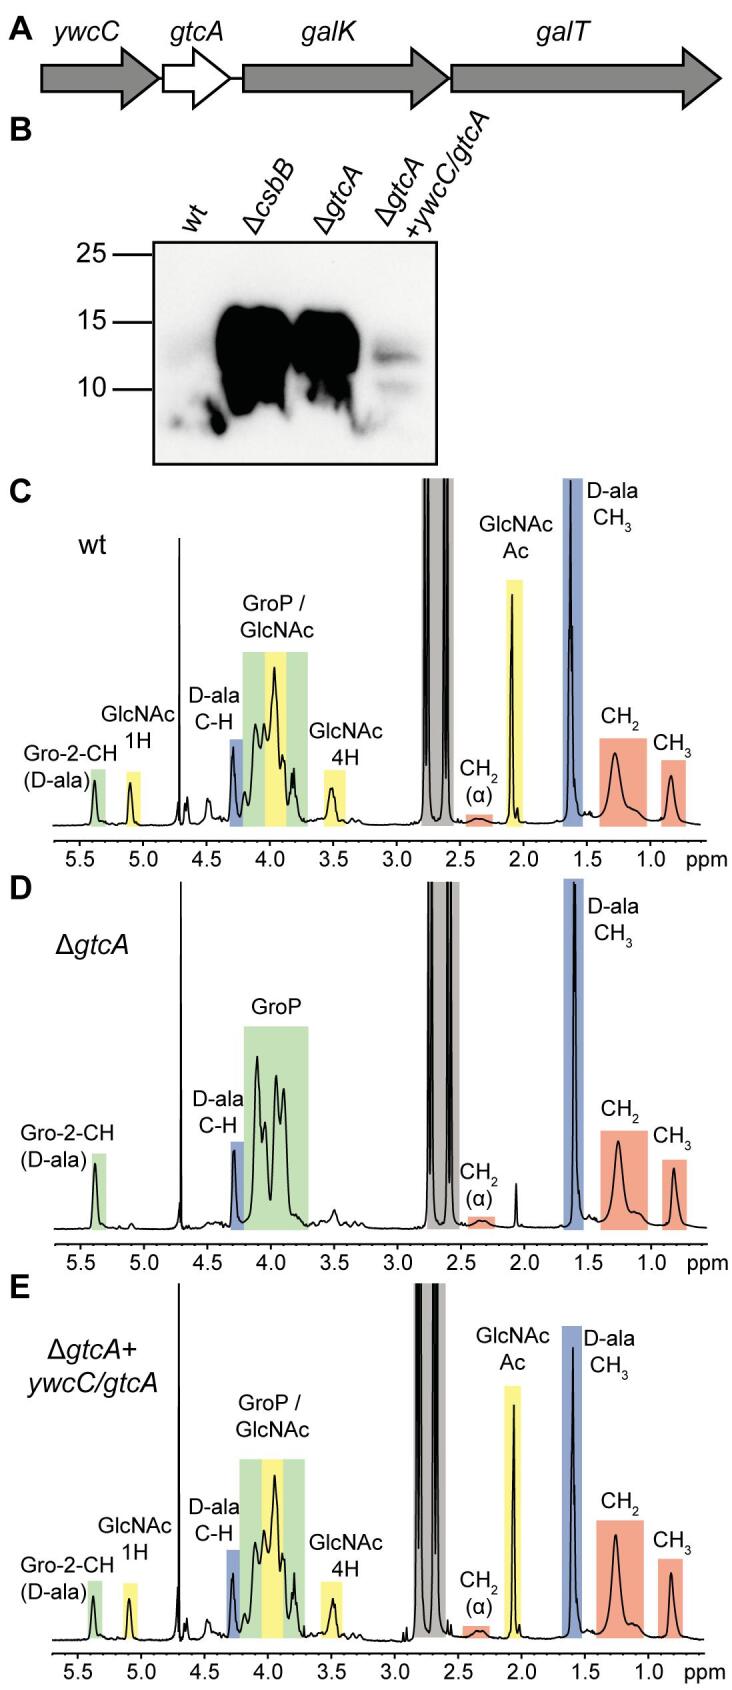
LTA production and NMR analysis of LTA isolated from wildtype B. subtilis 168 and the isogenic gtcA mutant and complementation strains. (A) Schematic representation of the ywcC/gtcA/galK/galT operon. (B) Analysis of LTA by western blot. Cell extracts of B. subtilis strain 168 (wt), the gtcA mutant and the gtcA complementation strain (gtcA + ywcC/gtcA) were prepared and separated on a 15% SDS-PAGE gel. Samples were standardised based on culture OD600 readings as described in the methods section. LTA was detected by western blot using a polyglycerolphosphate-specific monoclonal antibody. Cell extract of strain csbB was included as positive control (Rismondo et al., 2018). One representative result of four independent experiments is shown. (C-E) NMR spectra of LTA produced by (C) B. subtilis 168 (wt), (D) the gtcA mutant and (E) the gtcA complementation strain. Peaks of nonexchangeable protons were assigned to the different LTA components based on previously published spectra and highlighted in colored boxes (Wörmann et al., 2011, Morath et al., 2001, Morath et al., 2002a, Morath et al., 2002b). The spectra are representatives of two independent experiments.